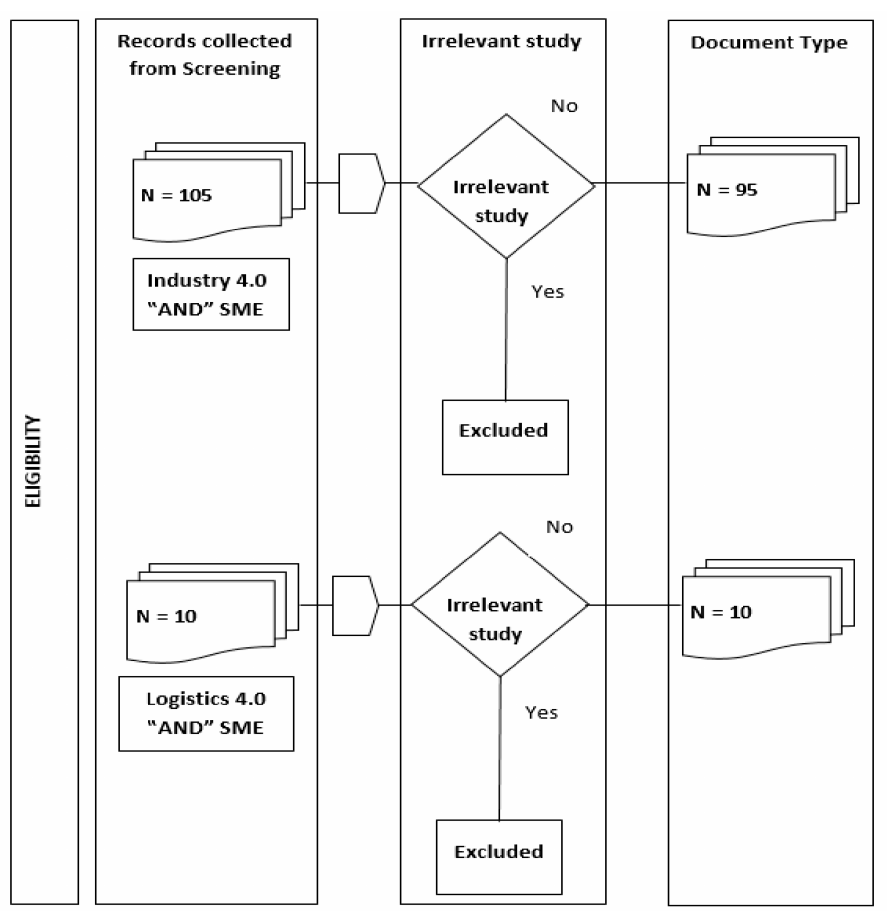
Figure 8. Eligibility step of the PRISMA framework. Source: own study, based on the PRISMA methodology.